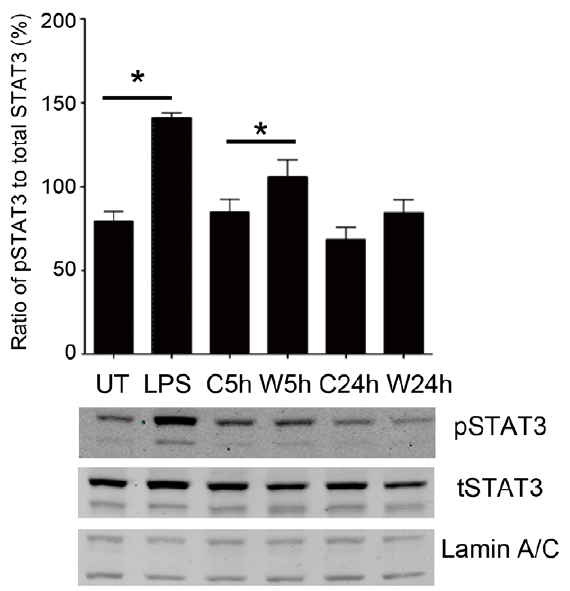
Figure 4. Wnt3a increased levels of nuclear phospho-STAT3. Nuclear fractions were prepared from cells treated with Wnt3a or control for 5 hr (W 5 h, C 5 h), or 24 hr (W 24 h, C 24 h). Lipopolysaccharide (LPS, 100 ng/ml, 5 hr) was used as a positive control, and untreated cells (UT) as the negative control. The blots were probed with antibodies against pSTAT3, total STAT3 (tSTAT3), and the nuclear marker protein lamin A/C. The 5 hr Wnt3a treatment increased the pSTAT3/tSTAT3 ratio by 25% compared with control (n=3, p =0.043), confirming that Wnt3a activates STAT3 and induces translocation into the nucleus. Representative blots for each antibody are shown.